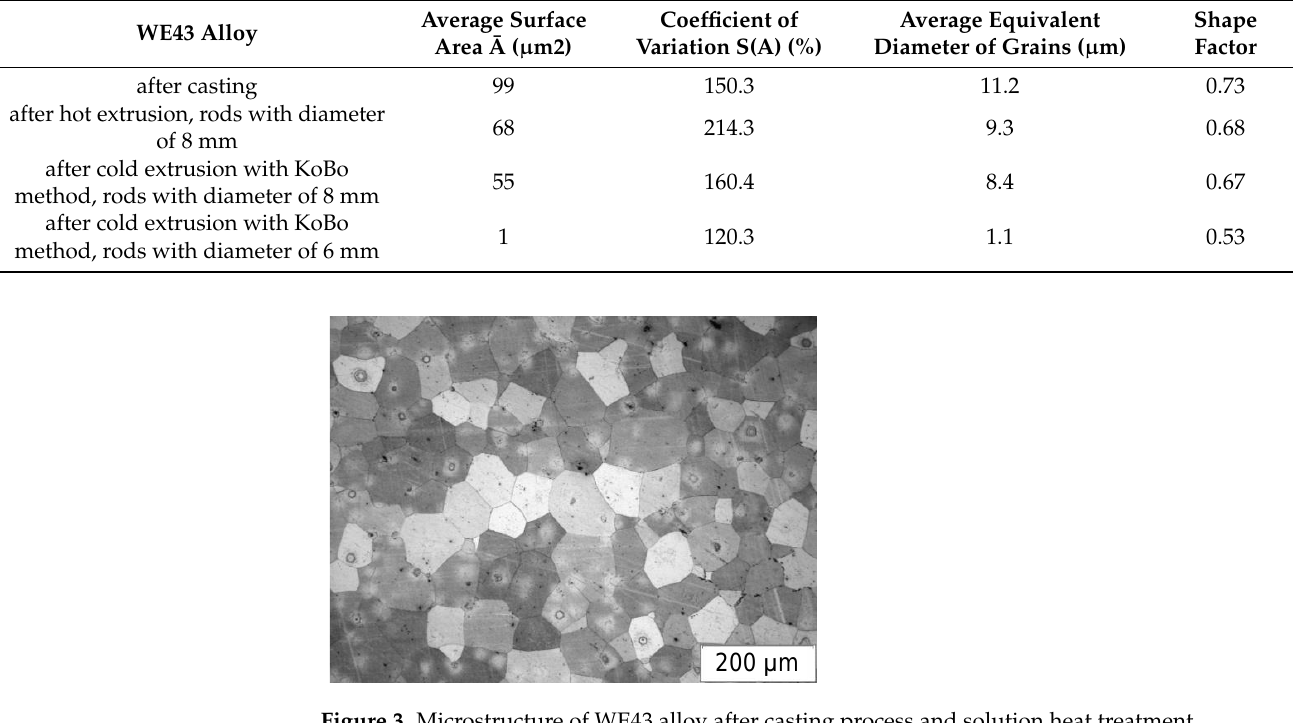
Table 2. Results of quantitative characterization of the WE43 alloy after applying the KoBo method. Figure 2. The appearance of samples for the tensile test and after the test.